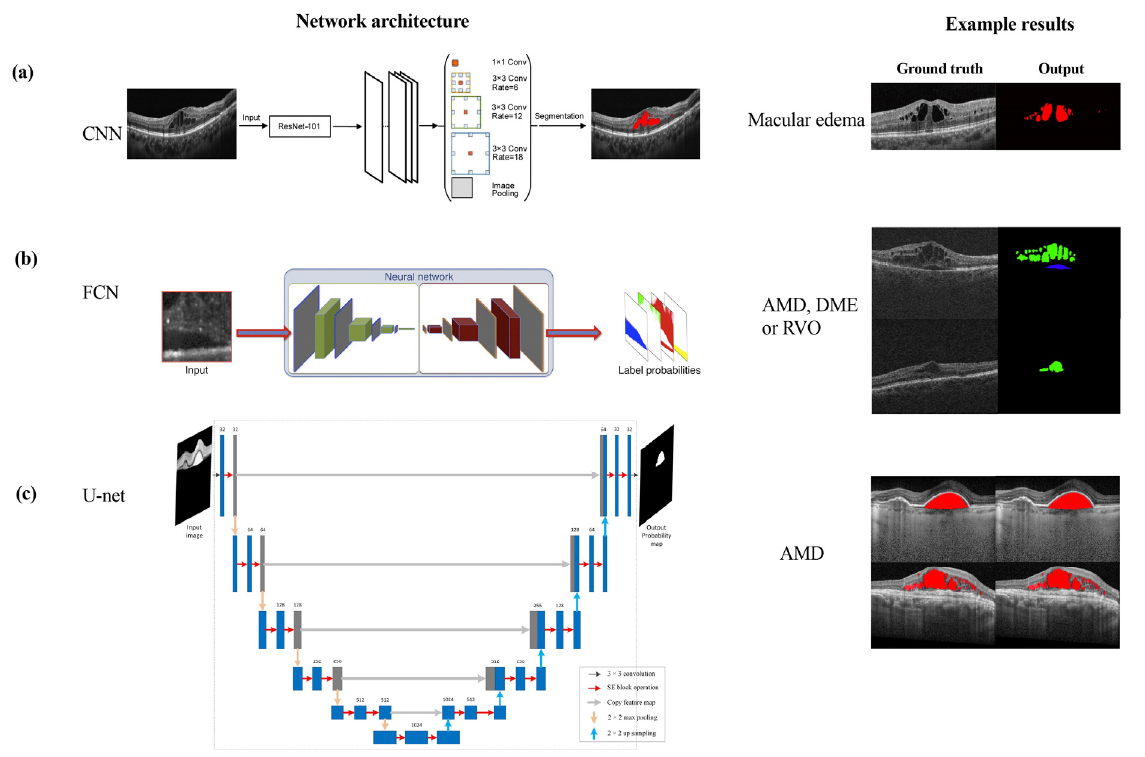
Figure 5. Comparison of three different neural network structures and their respective outcomes regarding segmentation results. The first structure, represented in ( a ), is a CNN model specifically designed for OCT analysis in patients with macular edema [63]. The second structure, depicted in ( b ), is another FCN-based model, which is utilized for OCT analysis in patients suffering from AMD, DME, or RVO. Reprinted with permission from Ref. [64]. 2018, Schlegl.; ( c ) presents a U-net based model, which is specifically designed for OCT analysis of patients with AMD. Reprinted with permission from Ref. [72]. 2016, Wu. The colored regions in the right side images are the segmentation results.